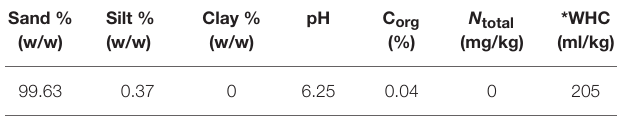
TABLE 1 | Soil Properties of ReviTec ® soil using in soil respiration tests. TABLE 2 | Slope, constant, and regression statistics for O 2 evolution and assimilation in three independent calibration tests with Chlorella vulgaris